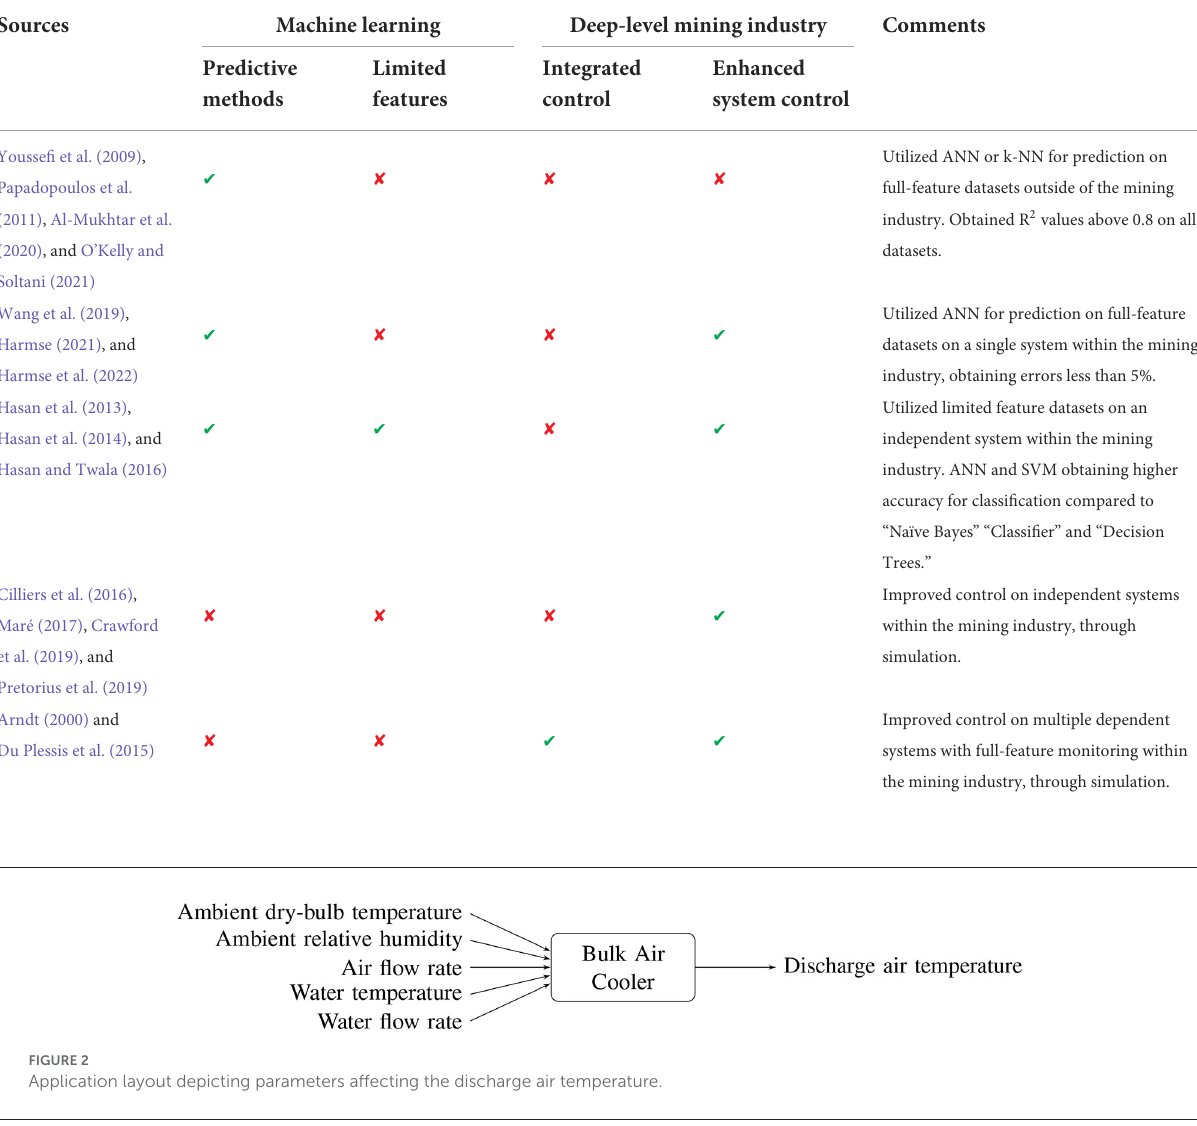
TABLE 1 State-of-the-art matrix indicating gaps in previous research.